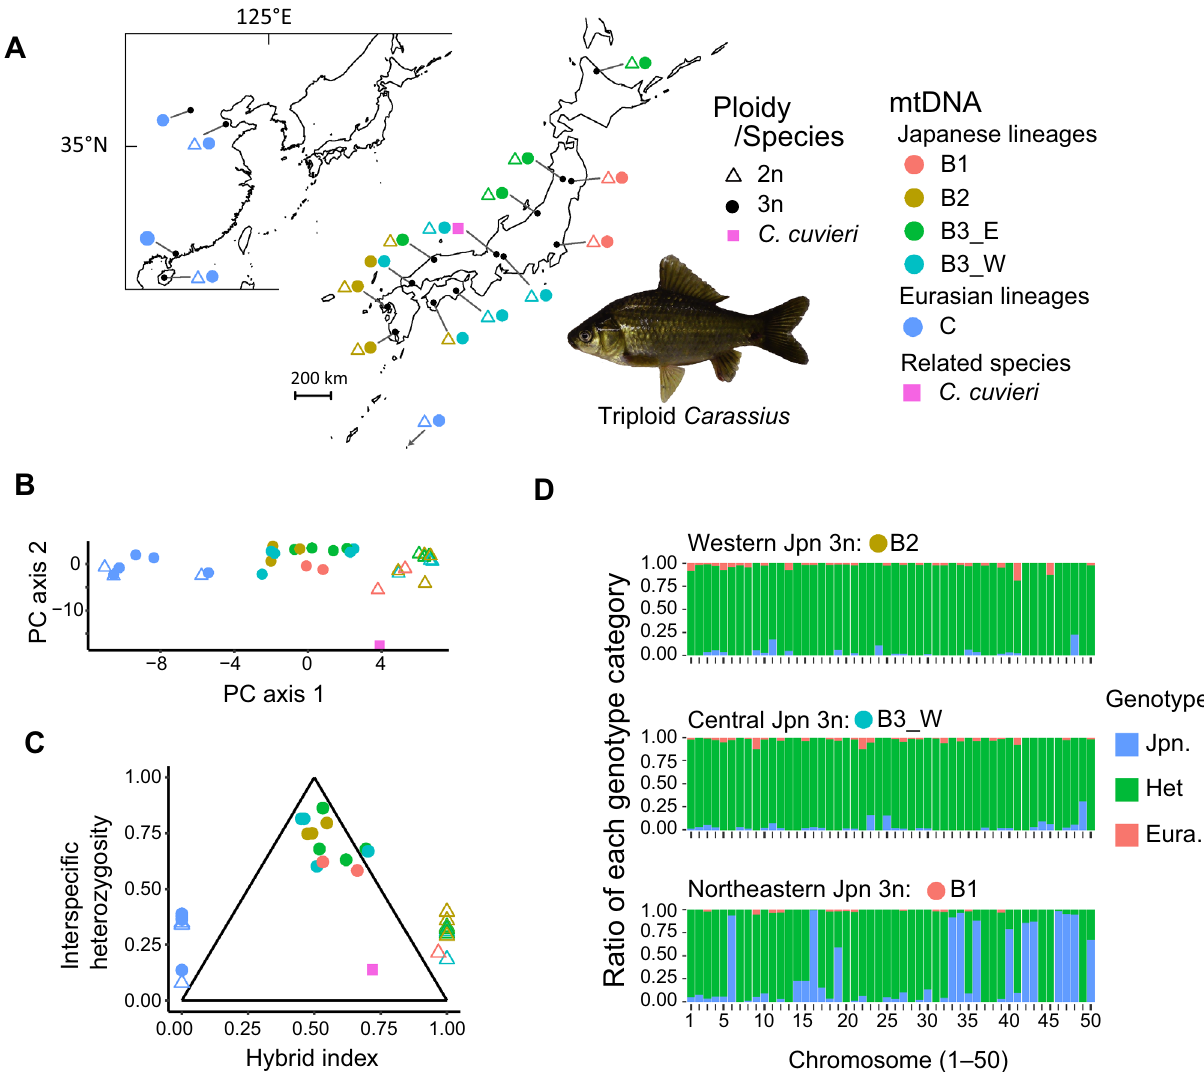
Figure 2. Genetic composition of triploid Carassius . ( A ) Locality, ploidy, and mitochondrial lineages of specimens used for target resequencing. Triangles indicate diploids, circles represent triploids, and a square represents C. cuvieri with colors corresponding to the mitochondrial lineages of the specimens. The map was generated using the R package mapdata. ( B ) PCA plot and ( C ) triangle plots of interspecific heterozygosity versus hybrid index based on the SNPs obtained from targeted resequencing. ( D ) Genetic composition across chromosomes in selected specimens of major mtDNA lineages of triploid Carassius in Japan based on dSNPs generated from RNA-seq. The ratios of genotype categories from dSNPs between the Japanese and Eurasian lineages are colored as Japanese homozygote (blue), Eurasian homozygote (red), and heterozygote